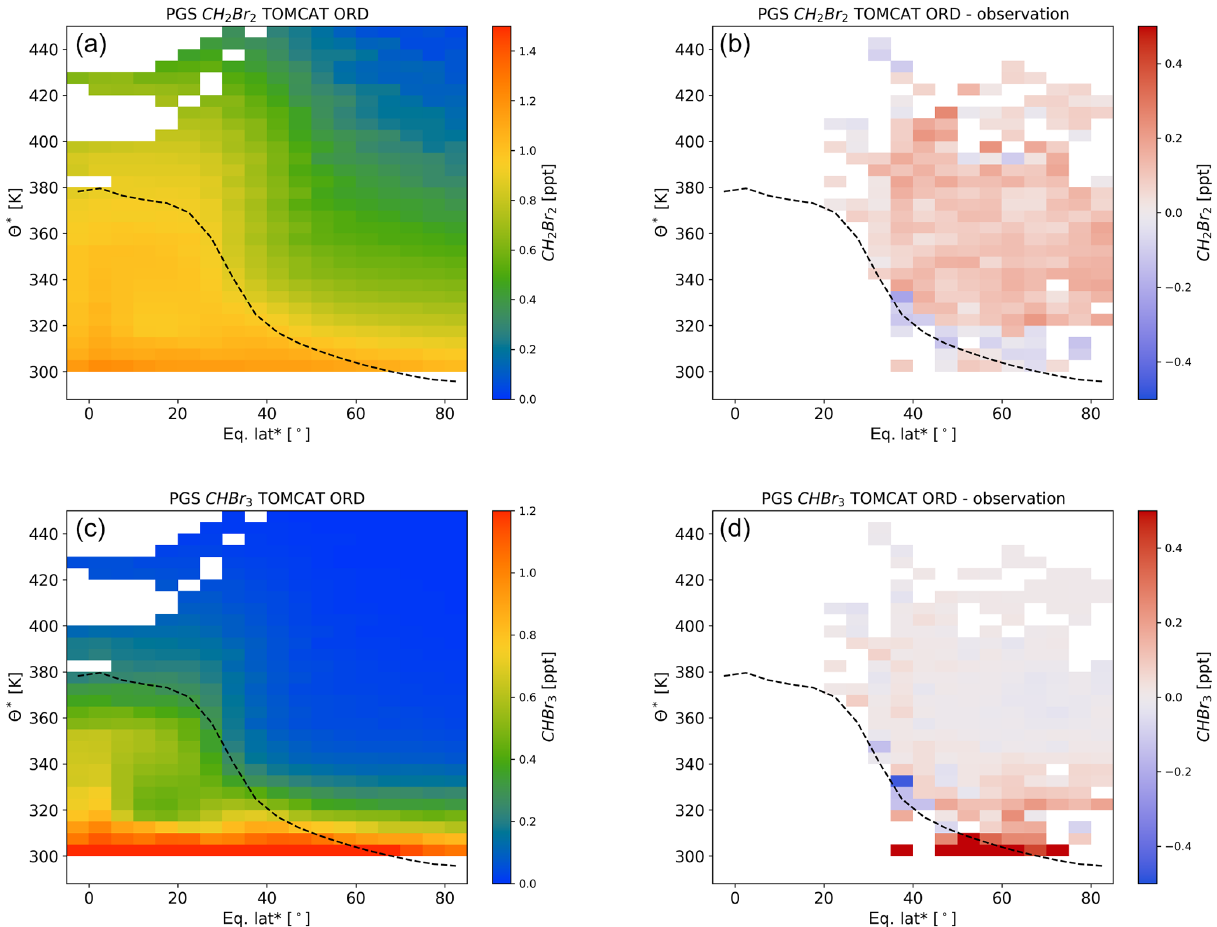
Figure 10. As Fig. 9 but using the Ordóñez et al. (2012) emission